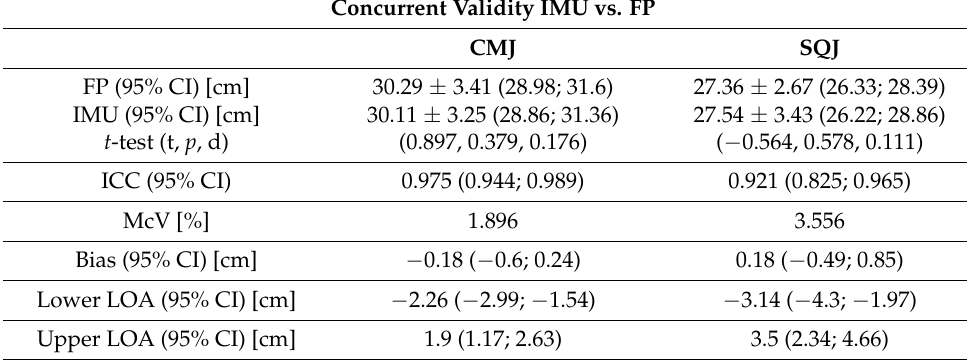
Table 2. Concurrent validity of an inertial measurement unit (IMU) vs. a force plate (FP) for vertical jump height